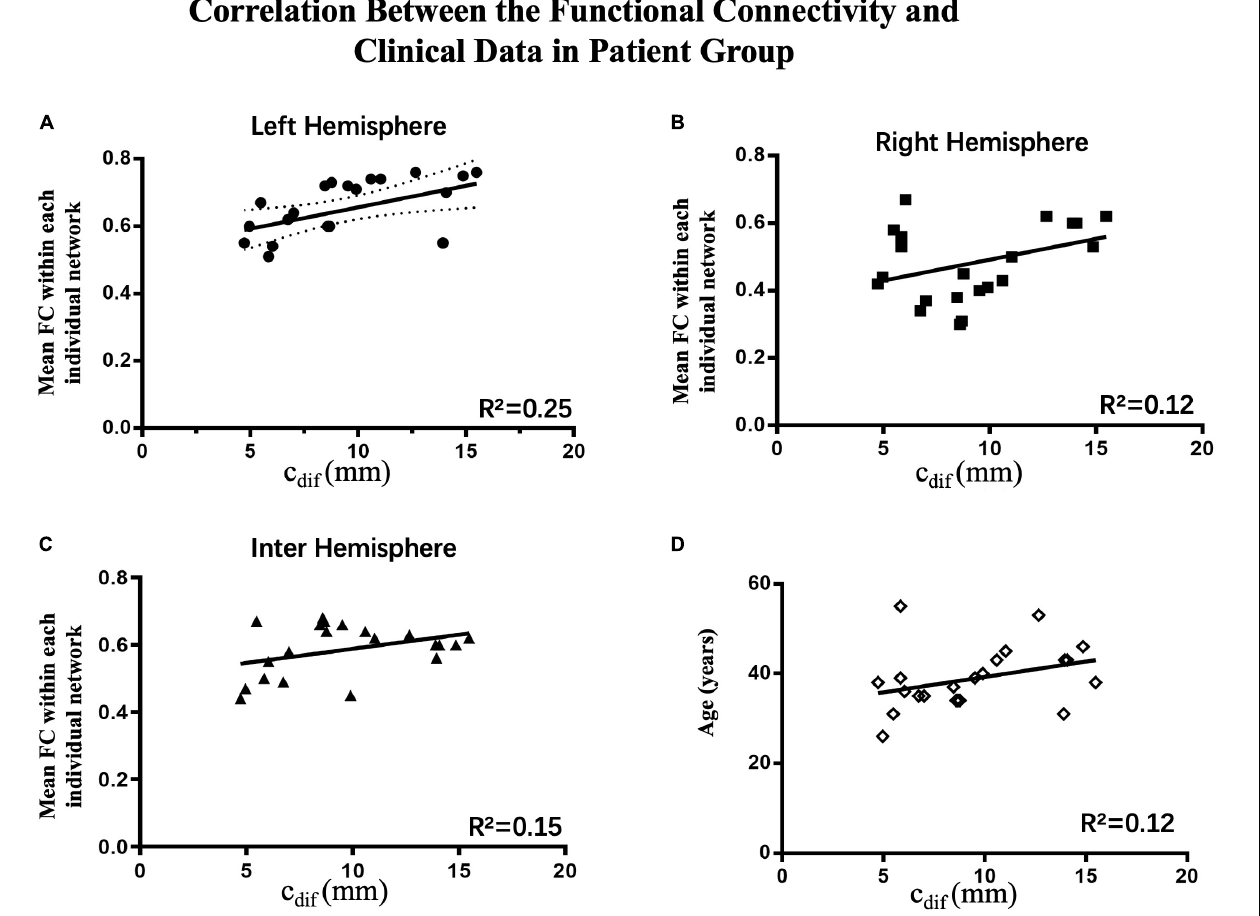
FIGURE 6 | Correlations between connectivity and clinical data in the patient group ( n = 22). The Pearson correlations of the average connectivity and age of individual patients with oral asymmetry are shown. (A) There was a significant correlation between functional connectivity in the ipsilesional network (left hemisphere, R 2 = 0.25, p < 0.05) and c dif ; increased connectivity correlated with greater oral asymmetry. (B–D) Contralesional hemispheric connectivity (right hemisphere, R 2 = 0.12, p > 0.05), interhemispheric connectivity ( R 2 = 0.13, p > 0.05), and age ( R 2 = 0.12, p > 0.05) were not significantly correlated with c dif